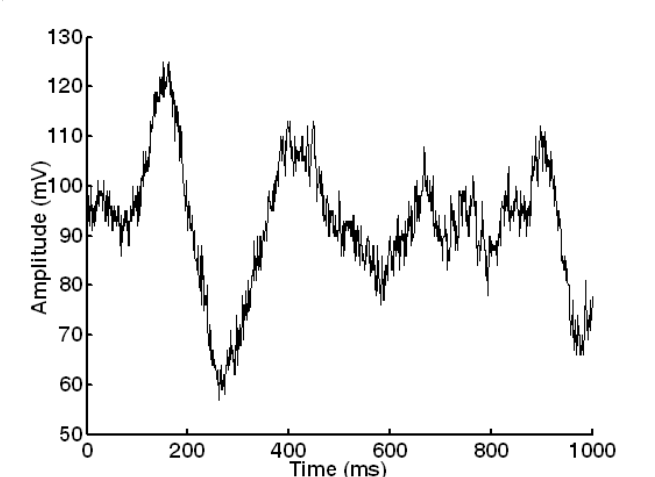
Figure 8. Seismic signal observed by a seismic sensor in a real world WSN deployment.